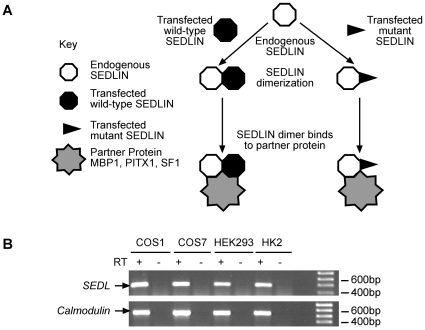
Schematic model for SEDLIN homodimerization and SEDL expression in common cell lines.(A) Homodimers that have formed between the transfected mutant cMyc-SEDLIN and the endogenously expressed wild-type SEDLIN could mask the loss of interaction between mutant SEDLINs and MBP1, PITX1 and SF1 in transfected COS7 cells. Thus, although the mutant SEDLIN may not directly interact with MBP1, PITX1 or SF1, the endogenously expressed SEDLIN will interact with these transcription factors, and hence the resultant homodimers will overall be seen to interact with the transcription factors. This proposed model provides an explanation for the observed results in the transfected cells. However, it is important to note that this situation of homodimers consisting of a wild-type and mutant SEDLIN would not normally occur in males affected with SEDT, as they are hemizygous and their cells would normally express the mutant SEDLIN; however this situation would occur in SEDT heterozygous carrier females because the SEDL gene escapes X-chromosome inactivation [13] and hence their cells would express both the wild-type and mutant SEDLINs. (B) RT-PCR analysis was used to detect the endogenous expression of SEDL in COS7, COS1, HEK293 and HK2 kidney cells, as a reliable SEDLIN antibody is not available. Detection of Calmodulin expression was used as an internal control for RNA quality and concentration; (+) with RTase, (−) without RTase.